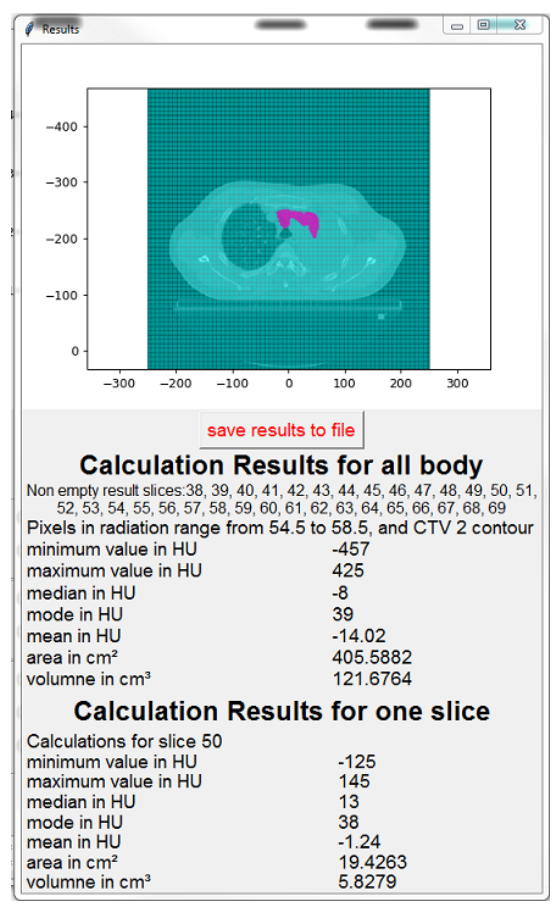
Figure 22. The result window with the calculation results. When the whole body option is chosen, it is possible to scroll through CT